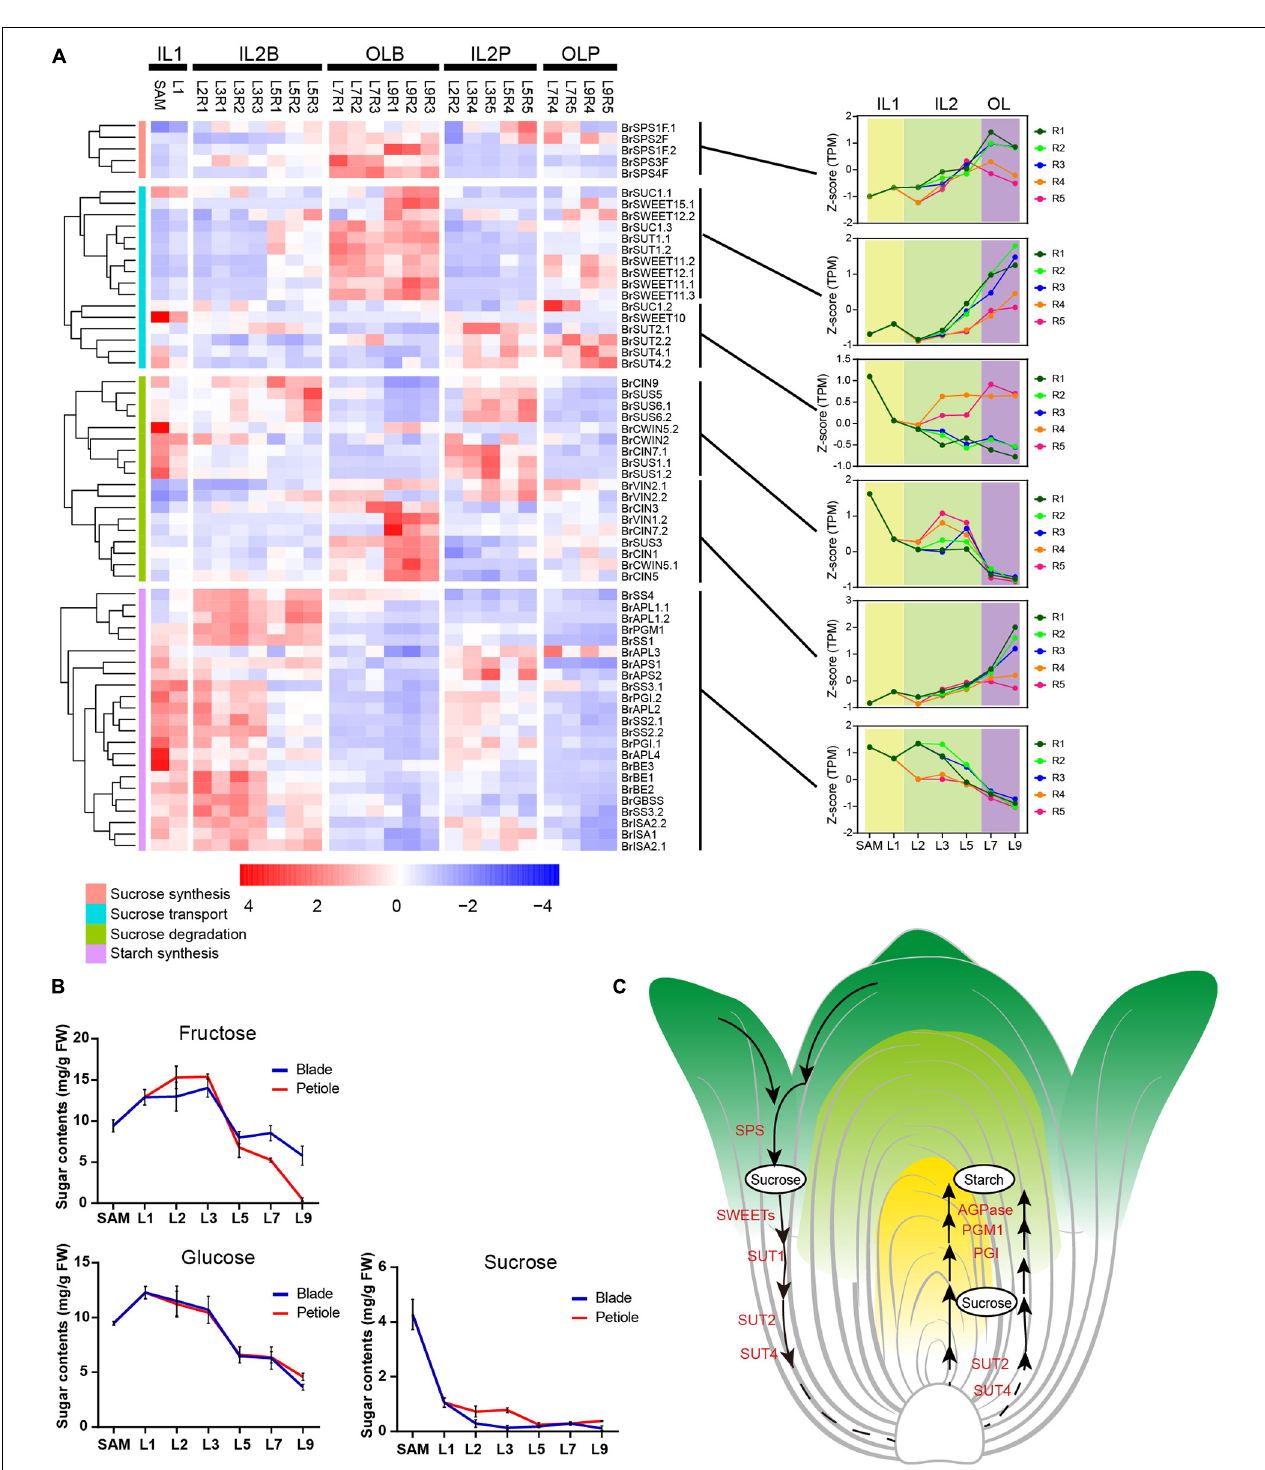
FIGURE 5 | The expression pattern of starch, sucrose and transport genes in leafy head. (A) Expression profiles of the genes related to sucrose synthesis, transport, degradation, and starch synthesis. For each gene, expression data were Z-score standardized. (B) Soluble sugar content in different leaves. The X axis depicts 12 samples, and the y axis depicts the sugar content. Error bars represent the SD (n = 2). (C) A model proposed for sucrose synthesis, transport, degradation and starch synthesis in leafy head.